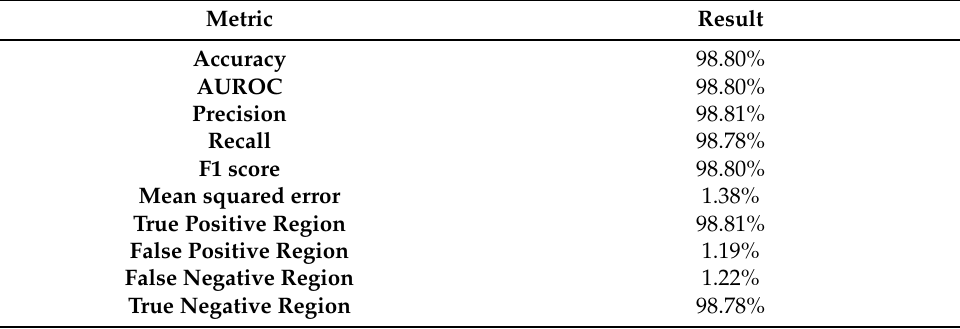
Table 3. Kernel level test metrics with the final